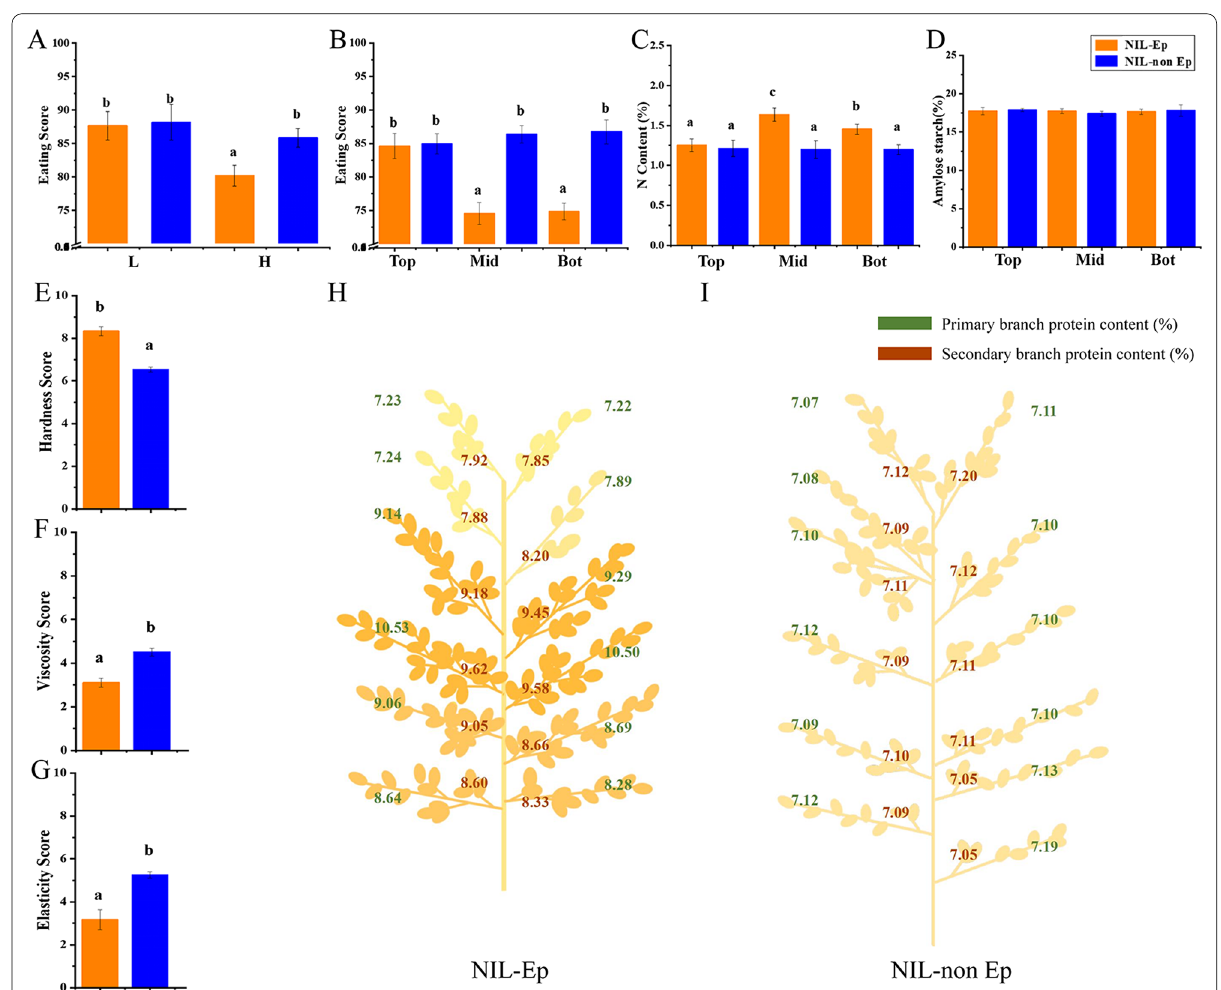
Fig. 3 The eating quality performance and grain protein, starch content of NIL-Ep and NIL-non Ep plants. A Eating quality under two nitrogen fertilizer treatments. L , H Low and high nitrogen treatments respectively. B Eating quality of different panicle locations under H treatment, the panicle is divided into 3 parts namely top (top, from 1–1 to 4–2 panicle positons), middle (mid, from 5–1 to 8–2 panicle positons) and bottom (bot, from 9–1 to 12–2 panicle positons) respectively. C N content of different panicle locations under high nitrogen treatment. D Amylose content of different panicle locations under high nitrogen treatment. E – G Components of eating quality of NIL-Ep and NIL-non Ep under high nitrogen treatment. H , I Protein content (%) of different panicle locations under high nitrogen treatment. (a), (b) Significance at the 0.05